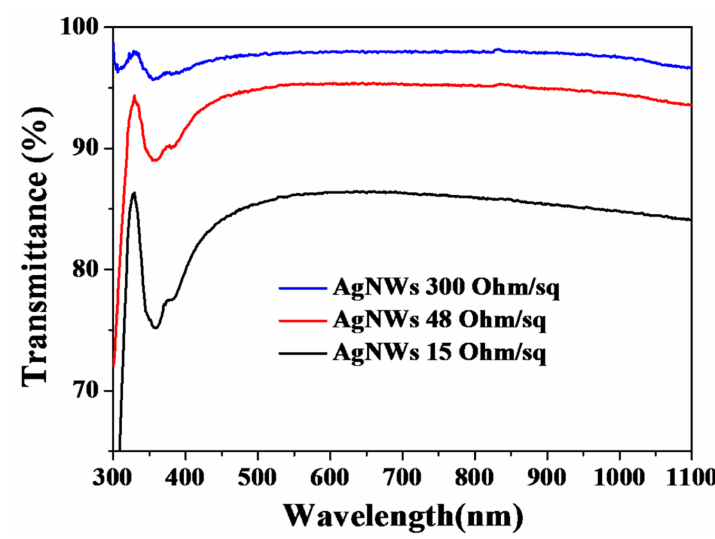
Figure 7. Optical transmittance of AgNW films, after subtraction of substrate absorbance.